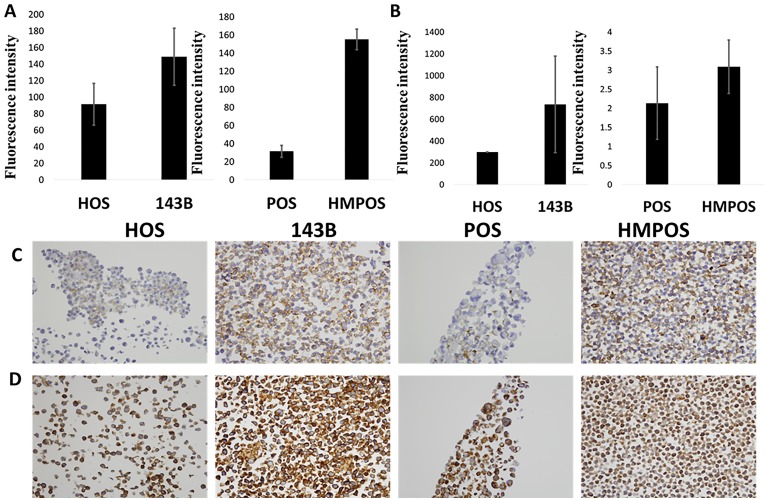
Flow cytometry fluorescence levels showing the expression of (A) CD44 and (B) CD147.Cell pellet immunohistochemistry showing the expression of (C) CD44 and (D) CD147. HOS and POS are the non- metastatic human and canine cell lines and 143B and HMPOS are the metastatic human and canine cell lines respectively. Details of quantification are indicated in SI.